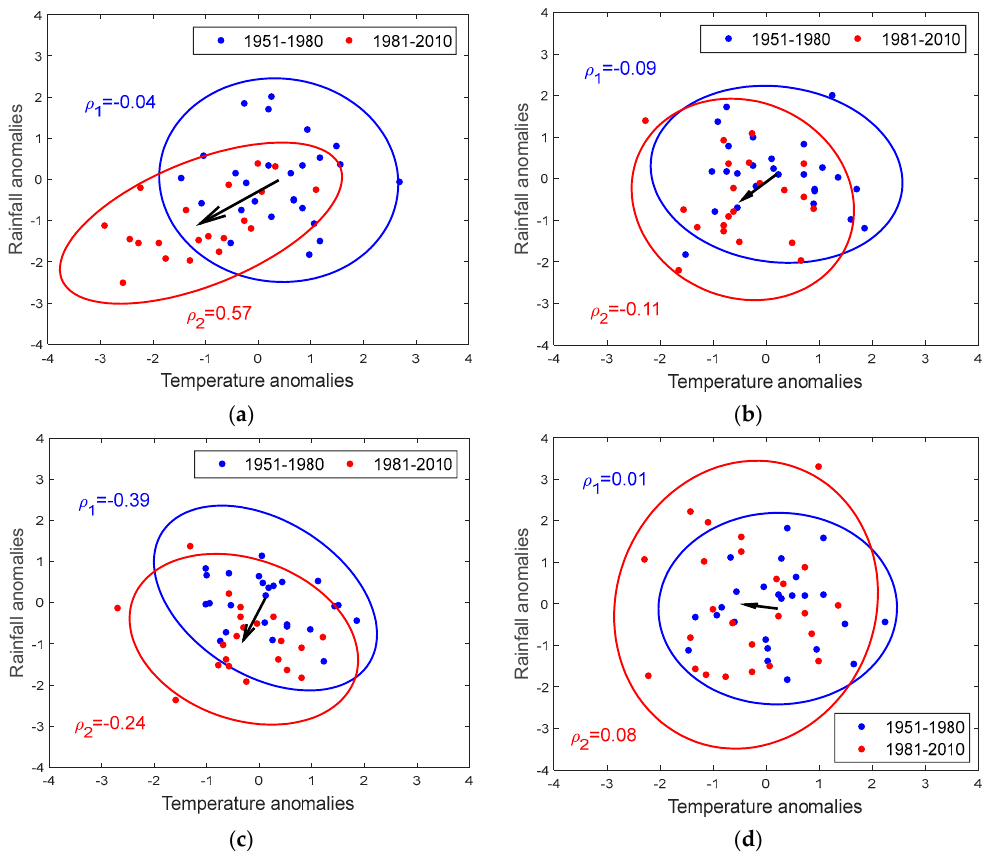
Figure 2. The 95% confidence ellipses for the winter season at gauge ( a ) 930; ( b ) 1010; ( c ) 1180; ( d ) 1680. present decreasing tendencies of temperature and rainfall anomalies, but only gauge 930 (Figure 3a) evidences a significant clear negative tendency ( − 0.8) of the temperature anomalies (Table 4). The Hotelling’s test is verified in spring only for gauge 930, and the t -test is verified for the same gauge only for the temperature anomalies. For the rotations, the only significant value has been observed at gauge 930 (69.2°), while not-significant values were detected regarding the deformations.